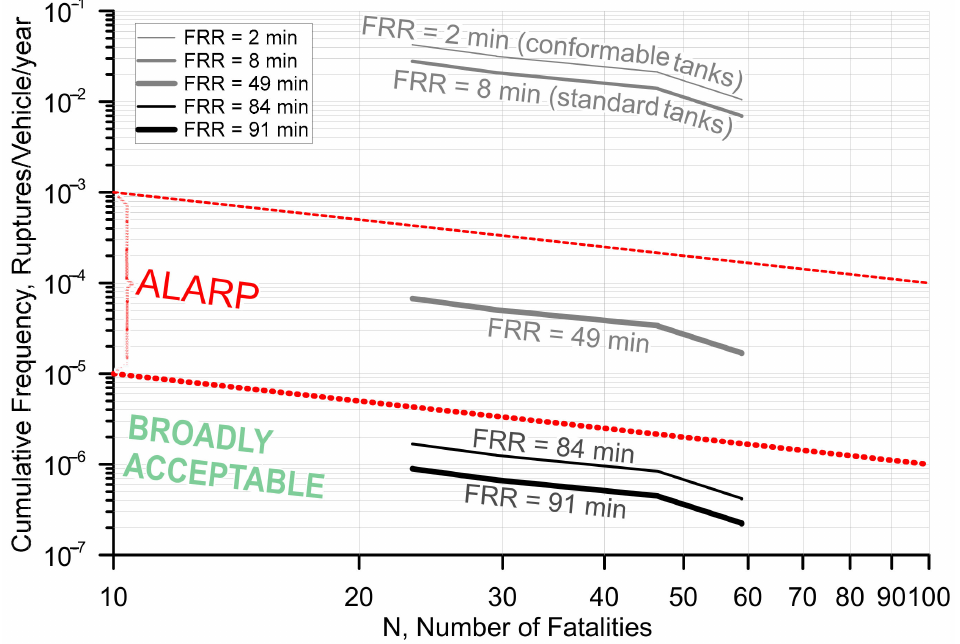
Figure 7. F–N curve—societal risk